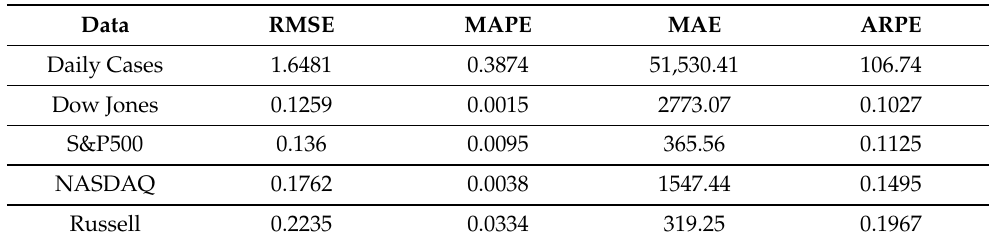
Table 13. Results from system of IG(a,b) OU model. The results reported are the best results from modeling a combination of U.S.A. COVID-19 cases with the stock market